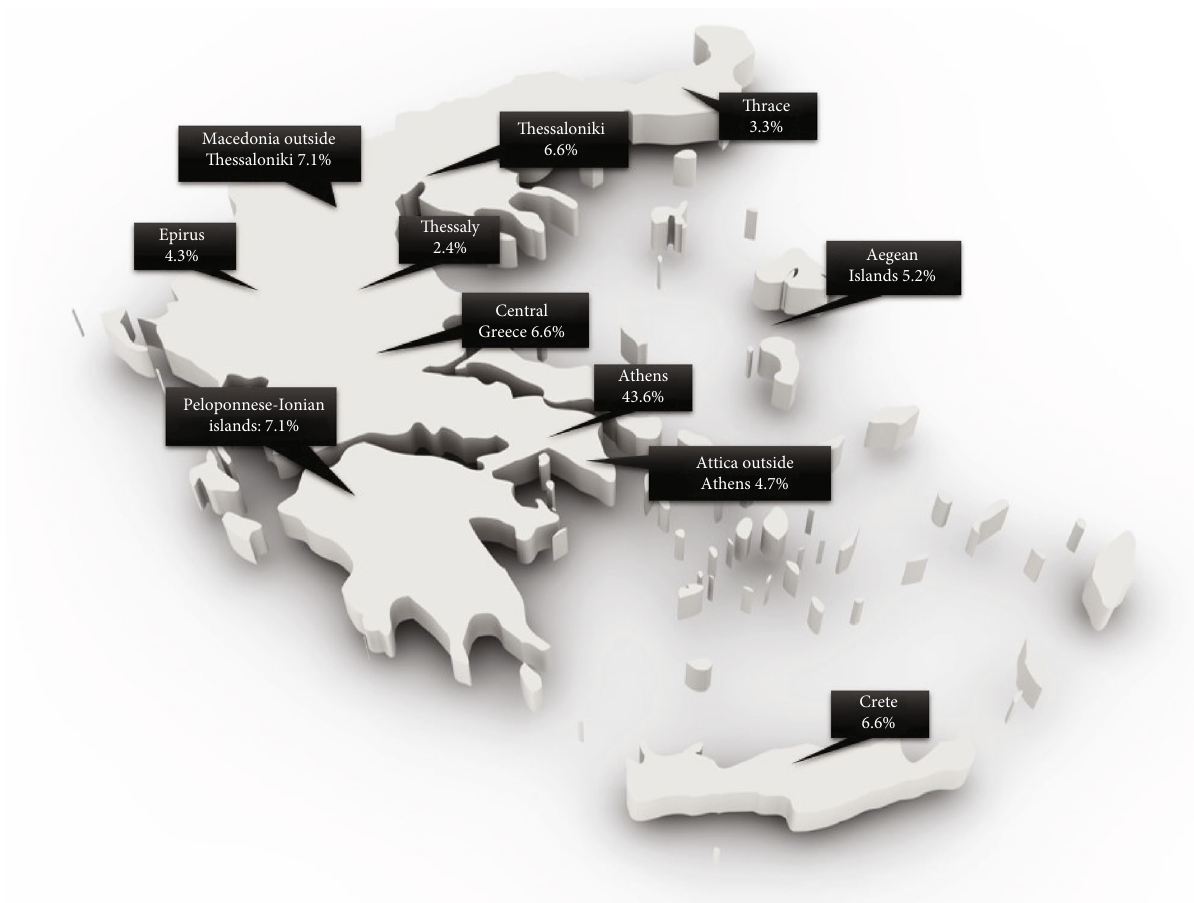
Figure 1: Geographical distribution of